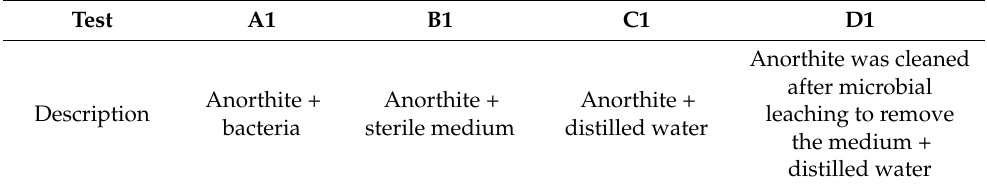
Table 3. Carbonation test